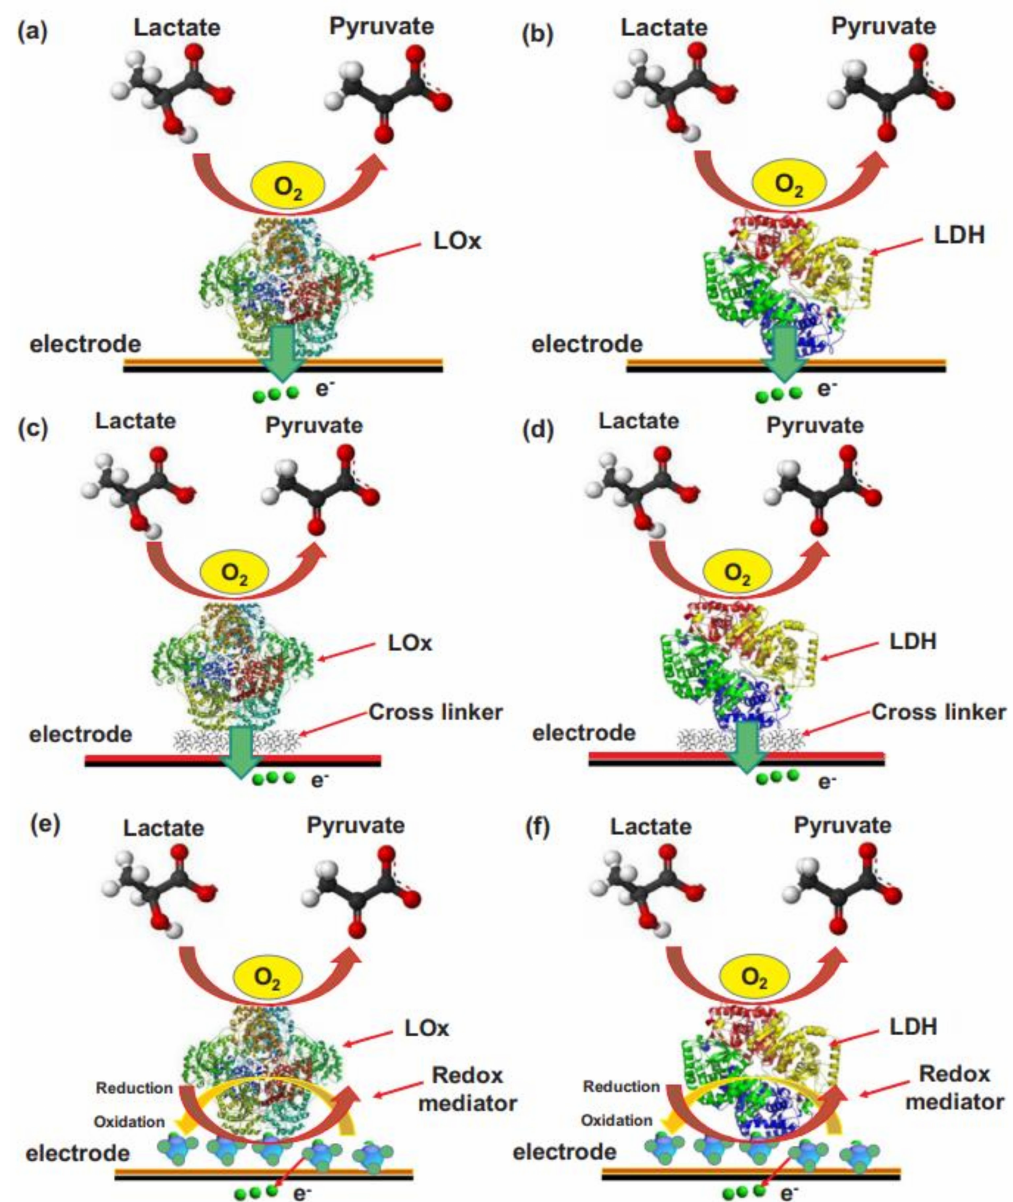
Figure 25. Diagram illustrating direct electron transport in ( a ) LOx, ( b ) LDH, ( c ) cross-linker attached LOx ( d ) cross-linker attached LDH; and for mediated electron transmission in ( e ) LDH and ( f ) LOx. (Reproduced from [555] with permission. Copyright 2018, Elsevier, Amsterdam, The